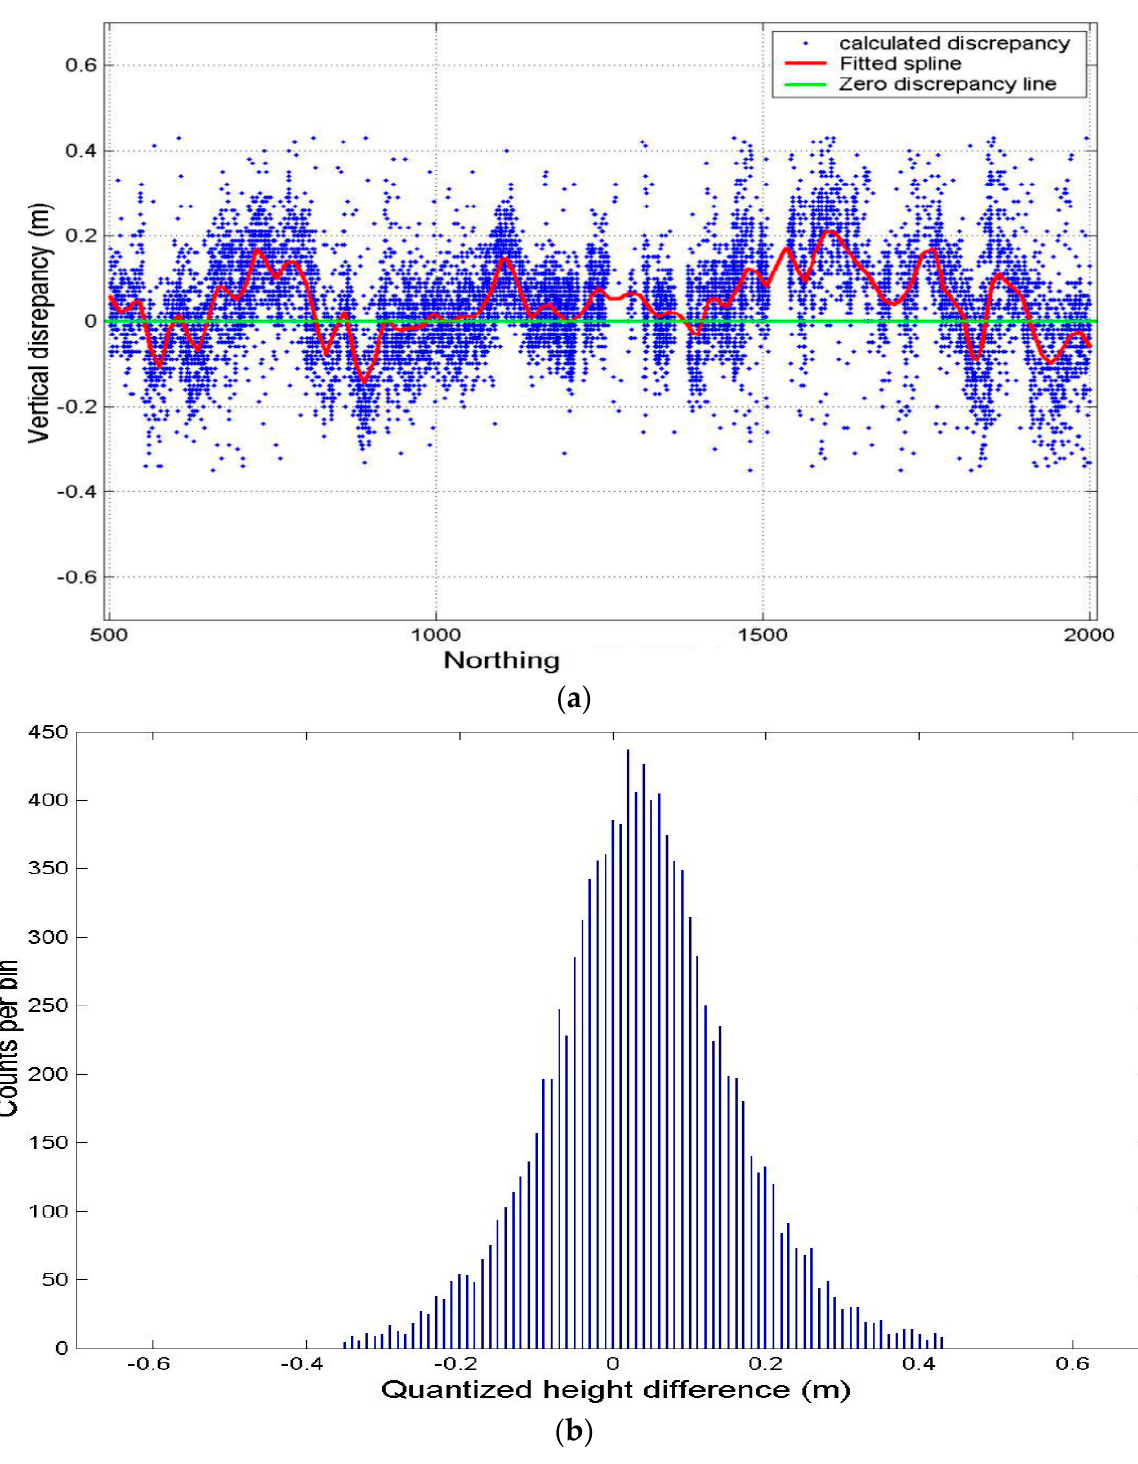
Figure 6. ( a ): Relative height discrepancy along the North–South direction in the overlap region between the 1st and the 2nd strip. ( b ): The histogram of relative height discrepancy between the 1st strip and the 2nd strip.